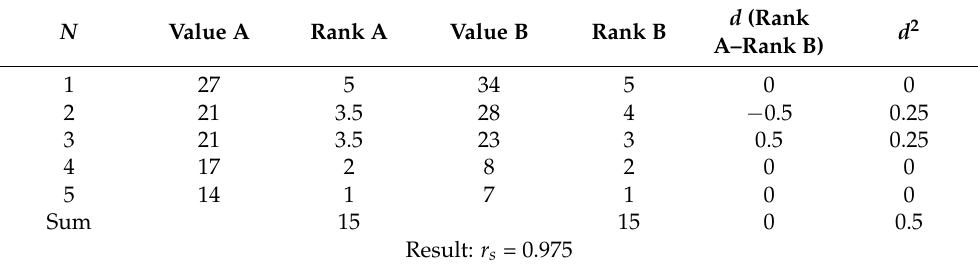
Table 2. Determination of Spearman’s rank linear correlation indicator based on the ratio of the assessment of changes in the efficiency of work associated with the expansion of the use of ICT and the readiness to use digital technologies in business of industrial enterprises of the Republic of Mordovia. N Value A